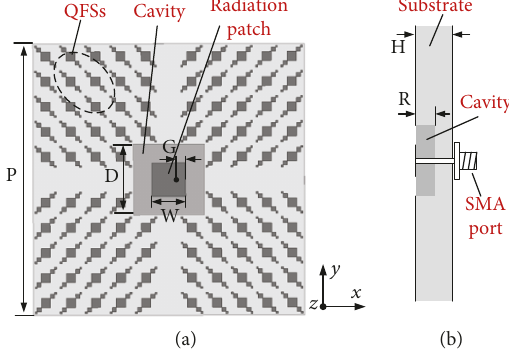
Figure 8: Con fi guration of the proposed antenna: (a) top view; (b) side view.